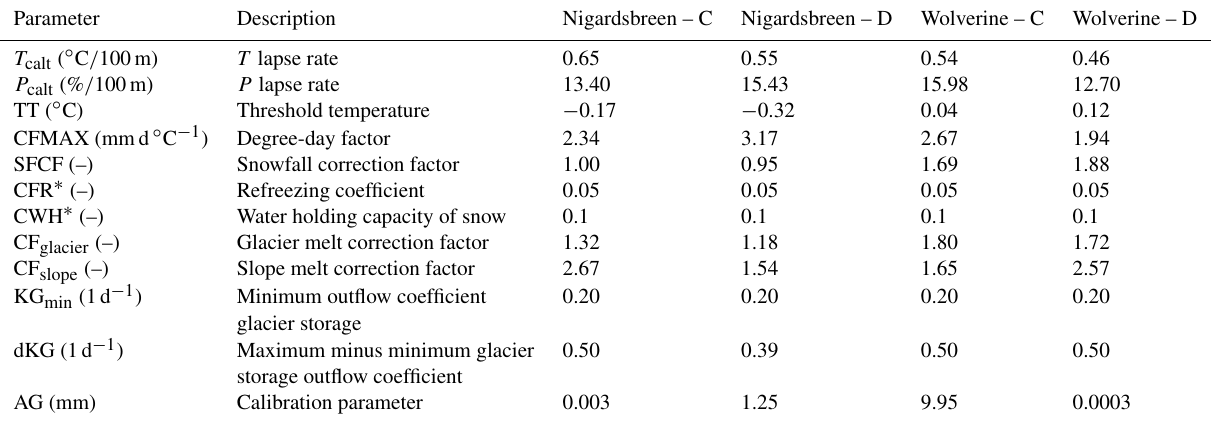
Table A1. Glacier and snow routine parameter values. All parameters were calibrated except CFR and CWH, indicated with ∗ . For each catchment, two parameter sets were obtained: one for the dynamical glacier conceptualisation (D) and one for the static glacier area con- ceptualisation